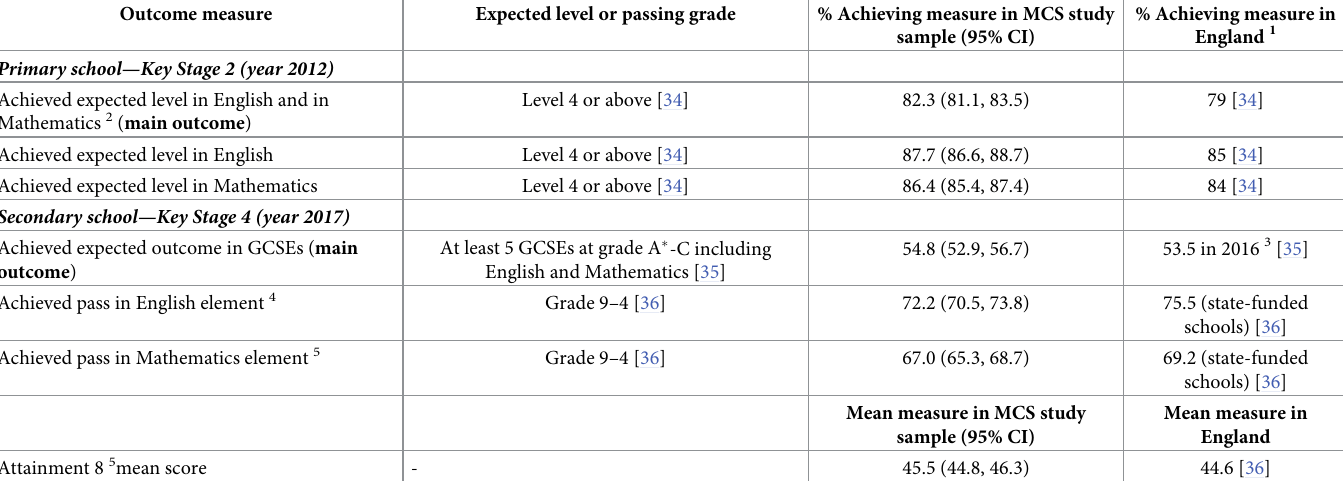
Table 2. Comparison between educational outcome measures in the Millennium Cohort Study samples and published national statistics at Key Stages 2 (age 11) and 4 (age 16). Outcome